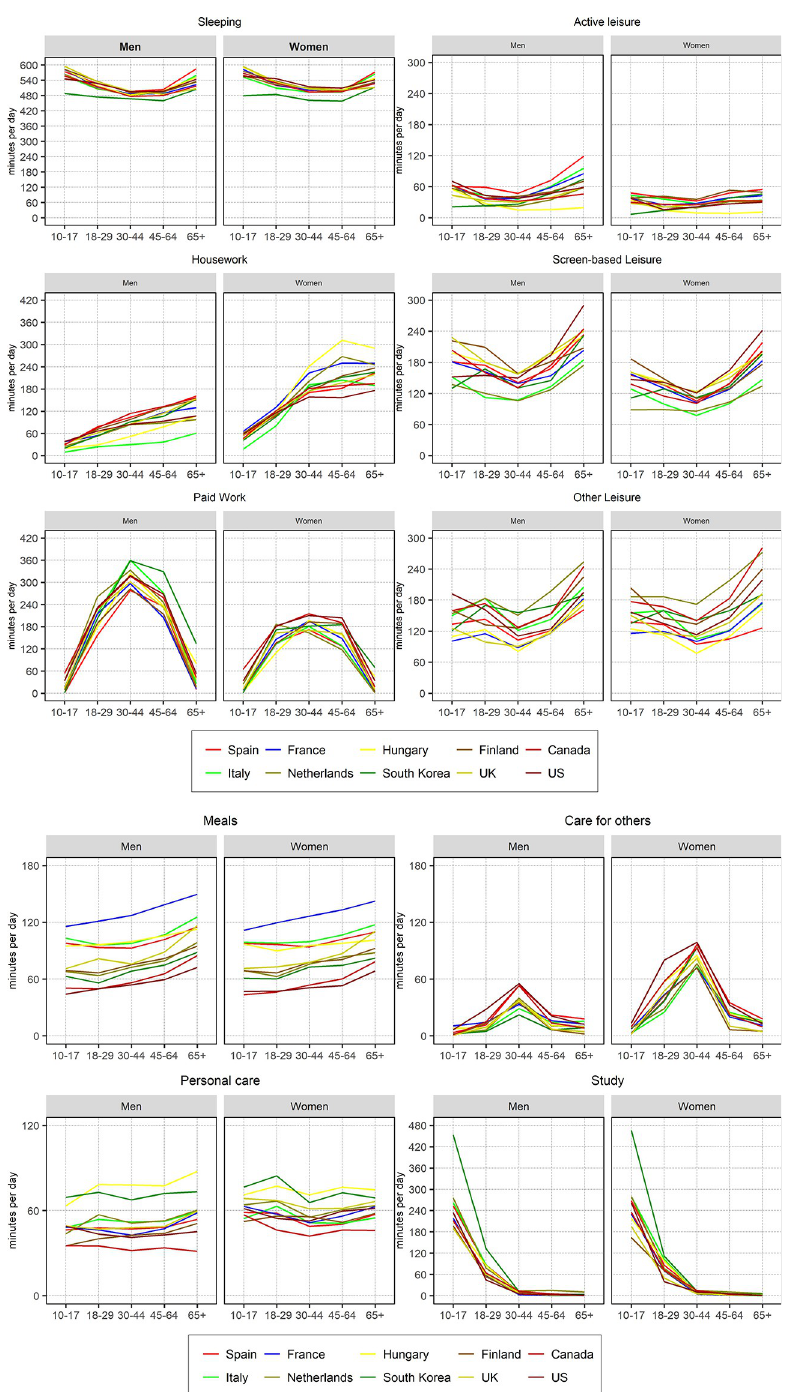
Fig 2. Average time by activity and age. Men and women by country. Source: Own calculations from the Multinational Time Use Study [32]. � Estimates of the figure available in Table 3.